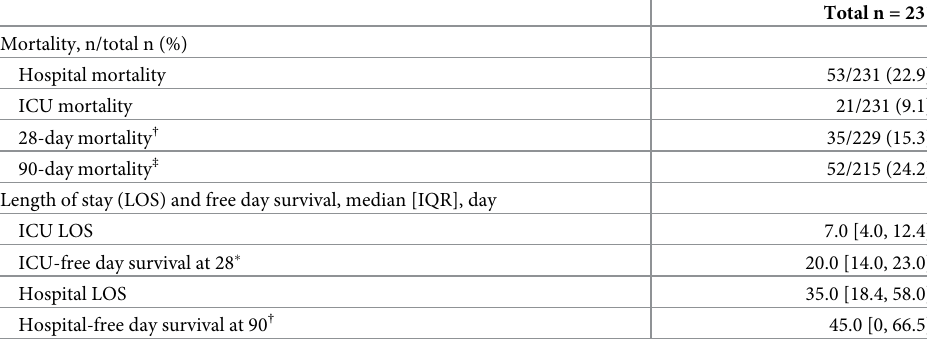
Table 2. Mortality, length of stay, and free day survival of the study